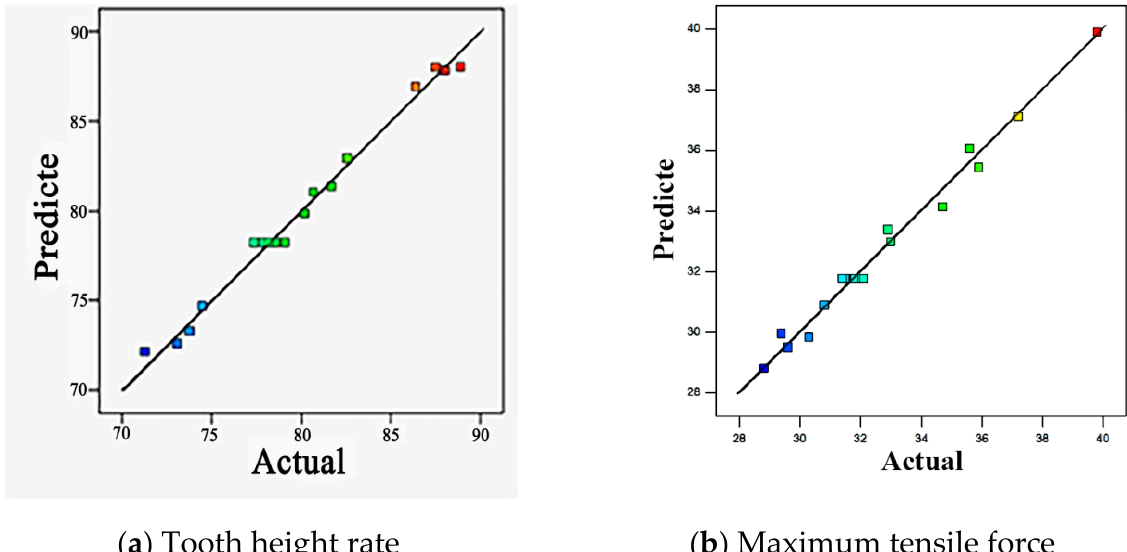
Figure 4. The correlation between the actual and predicted values.